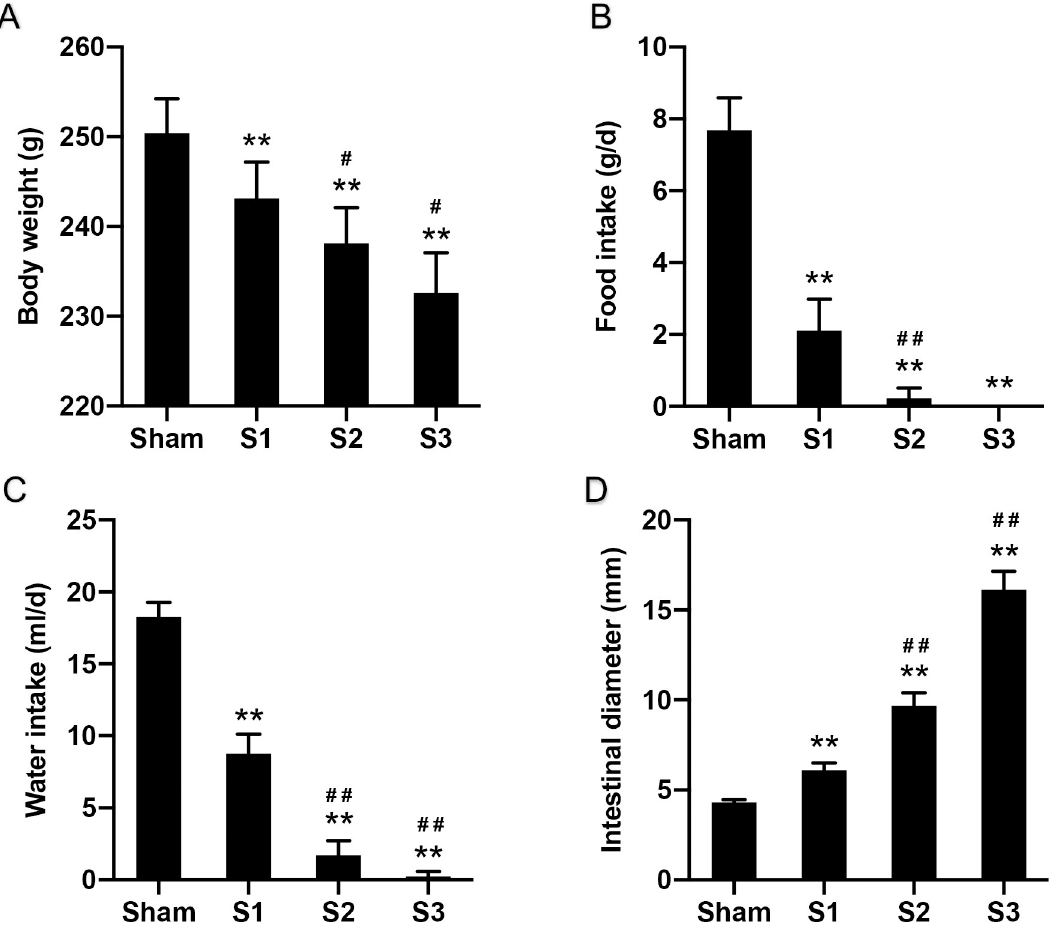
Fig 1. The general condition of the rats. Body weight (A), food intake (B), water intake (C), intestinal diameter (D) of the rats. Data are presented as the mean ± SD, n = 5. � P < 0.05, �� P < 0.01 vs. Sham group; # P < 0.05, ## P < 0.01 vs. the preceding group.